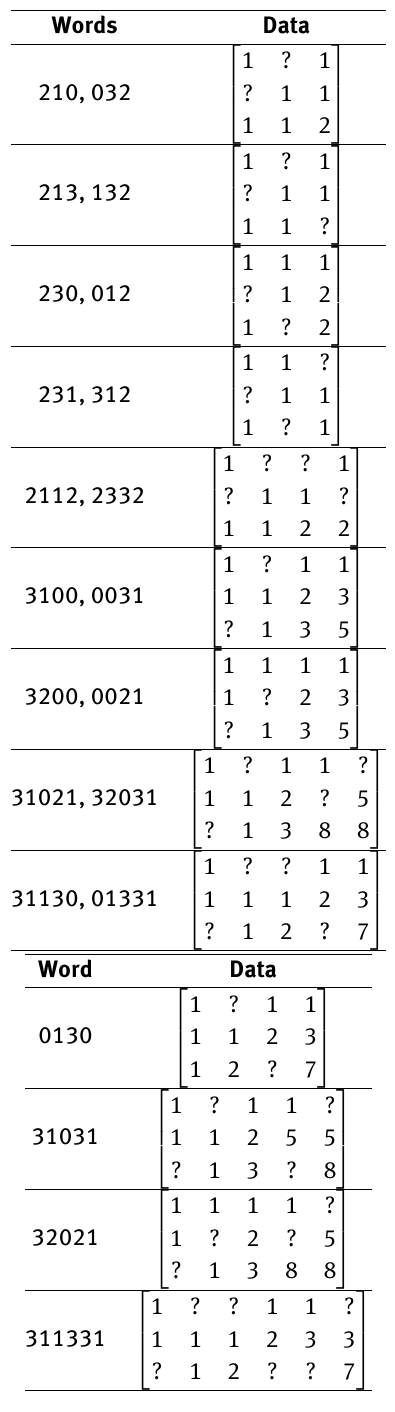
Table 1: List of 3 -by- n minimal obstructions up to symmetry